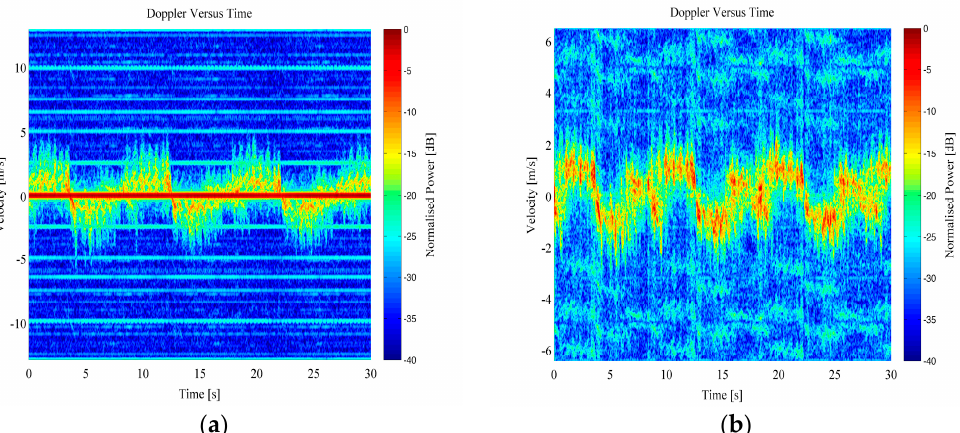
Figure 7. Example Doppler-time spectrogram from a person walking free handed: ( a ) RTI micro-Doppler; ( b ) MTI micro-Doppler.